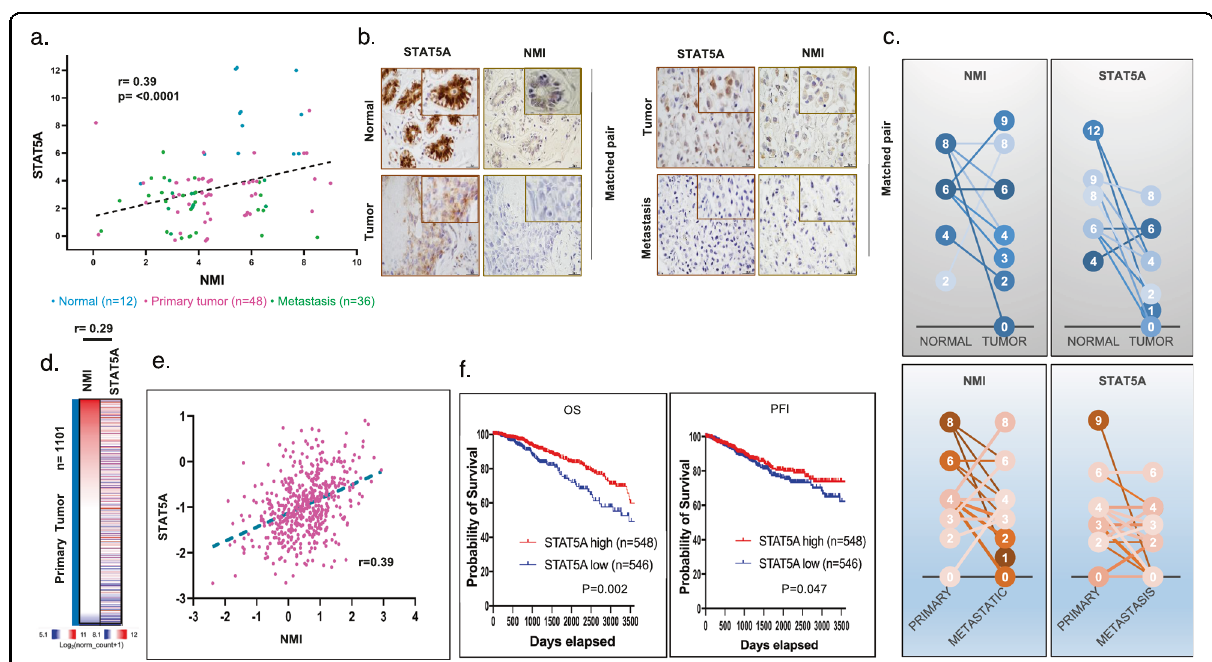
Fig. 4 NMI/STAT5A axis is downregulated in breast cancer and its expression is distinctive for less frequent metastasis and good prognosis. a Correlation of STAT5A and NMI immunoscore in human breast cancer TMA of normal breast tissues ( n = 12), primary breast tumors ( n = 48), and metastatic LN ( n = 36), graph represents a signi fi cant moderate correlation between NMI and STAT5A score (r = 0.39) ( p ≤ 0.0001). b Immunohistochemical staining for STAT5A and NMI on matched normal breast vs primary breast tumor (left panel) and matched primary breast tumor vs metastatic LN (right panel) c Immunoscore for STAT5A and NMI from matched human normal breast vs primary breast tumor and matched primary breast tumor vs metastatic LN. (Normal vs tumor NMI ( P = 0.17) STAT5A ( p = 0.001)) (Primary vs metastatic NMI ( p = 0.05) STAT5A ( p = 0.004)). The number in the circle represents immunoreactive score. The shade of color for individual circle is assigned it to distinguish matched sample. The line connects the matched samples from the same patients. d Heatmap of NMI, STAT5A, and JAK2 RNA-seq expression in TCGA 1101 primary human breast cancer. e Graph represents signi fi cant positive correlation between expression of STAT5A and NMI in TCGA (r = 0.39) ( p ≤ 0.0001). f TCGA data-based KM survival curve for STAT5A RNA-seq low and high-expressing patients. Graph shows signi fi cantly higher overall survival (OS) ( p = 0.002) and Progression-free interval (PFI) ( p = 0.047) in STAT5A high-expressing